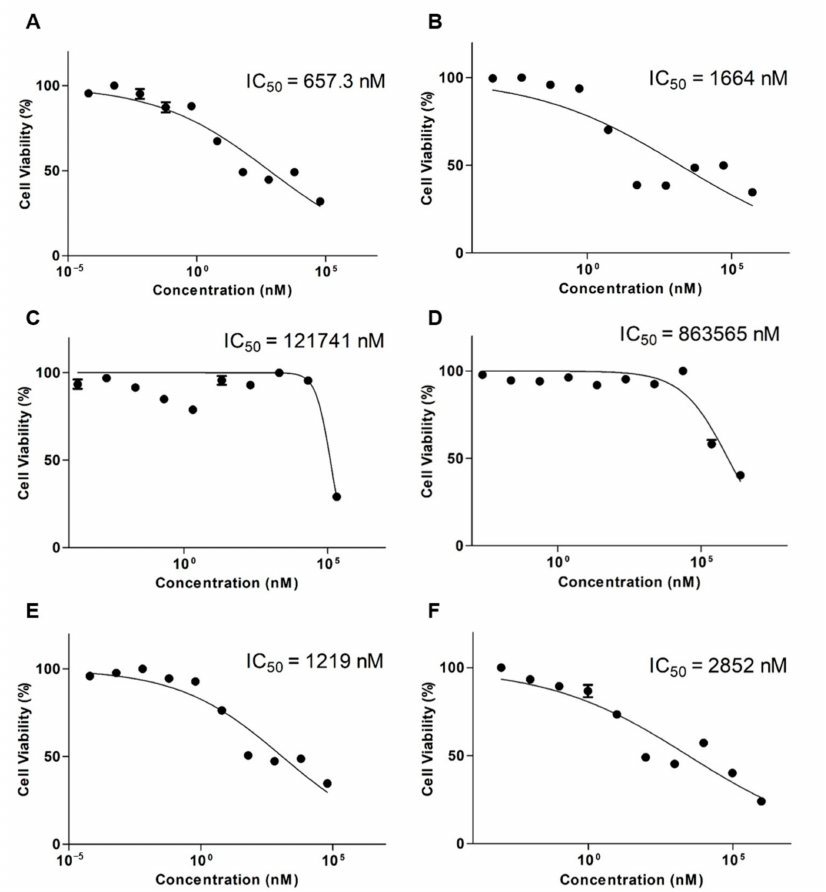
Figure 3. In vitro cytotoxicity assay results after the treatment of A549 cells with ( A ) docetaxel (DTX) free drug, ( B ) DTX- loaded mPEG- b -PCL micelles, ( C ) osthol (OTH) free drug, ( D ) OTH-loaded mPEG- b -PCL micelles, ( E ) DTX/OTH free drug, and ( F ) DTX/OTH-loaded mPEG- b -PCL